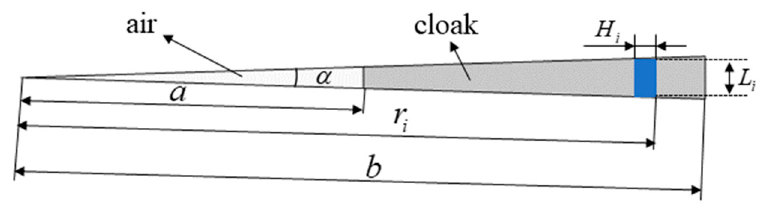
Figure 9. The distribution of the pentamode material cellular in the cloak.